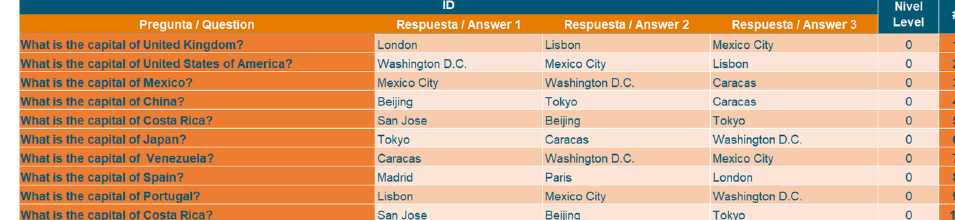
Figure 8. Example of 10 MCQ questions for gaming activities created using FastTest PlugIn.